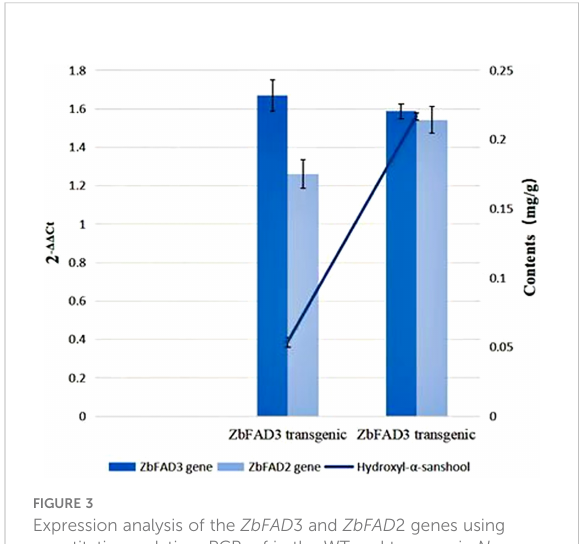
FIGURE 3 Expression analysis of the ZbFAD 3 and ZbFAD 2 genes using quantitative real-time PCR, of in the WT and transgenic N benthamiana